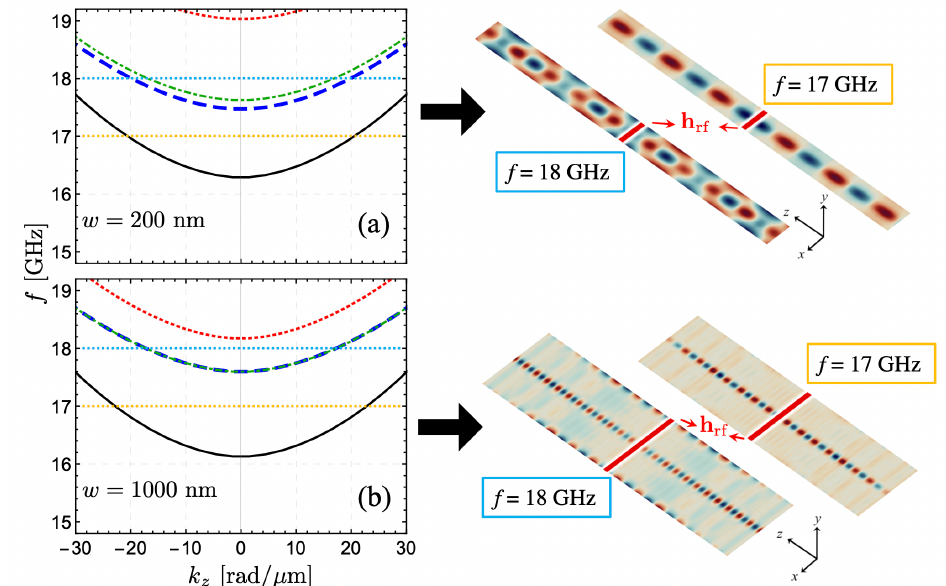
Figure 6. Calculated spin-wave dispersion and its respective profiles obtained from the micromag- netic simulations. In ( a ) and ( b ), the cases w = 200 nm and w = 1000 nm are respectively illustrated, where ξ = 100 nm and ∆ M s / M s = 0.5 are assumed in both cases. The different curves depict the low-frequency spin-wave modes. The SW propagation is simulated for f = 17 GHz and 18 GHz (dotted horizontal lines). At f = 17 GHz, the SWs are conducted along the nanostrip center, being this the unique excited mode, as the calculations predict. If the frequency of the field h rf is 18 GHz, both the edge and the channelized modes are